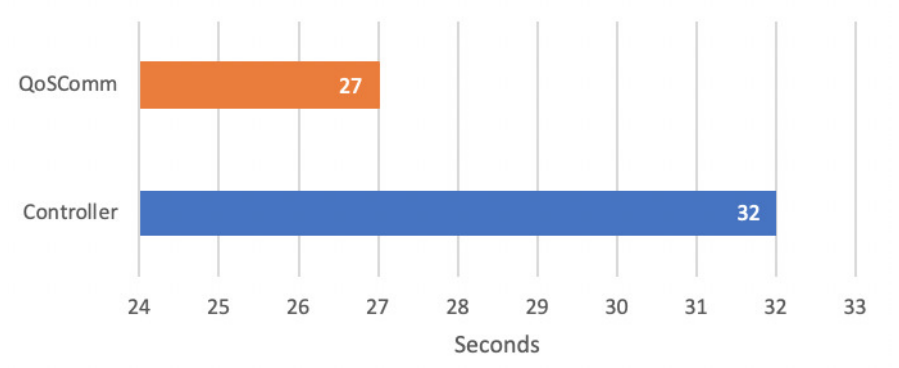
Figure 8. Data Flow forwarding method comparison for MPI Application. Average completion time results using simulation topology. STDEV: Controller: 1.15, QoSComm: